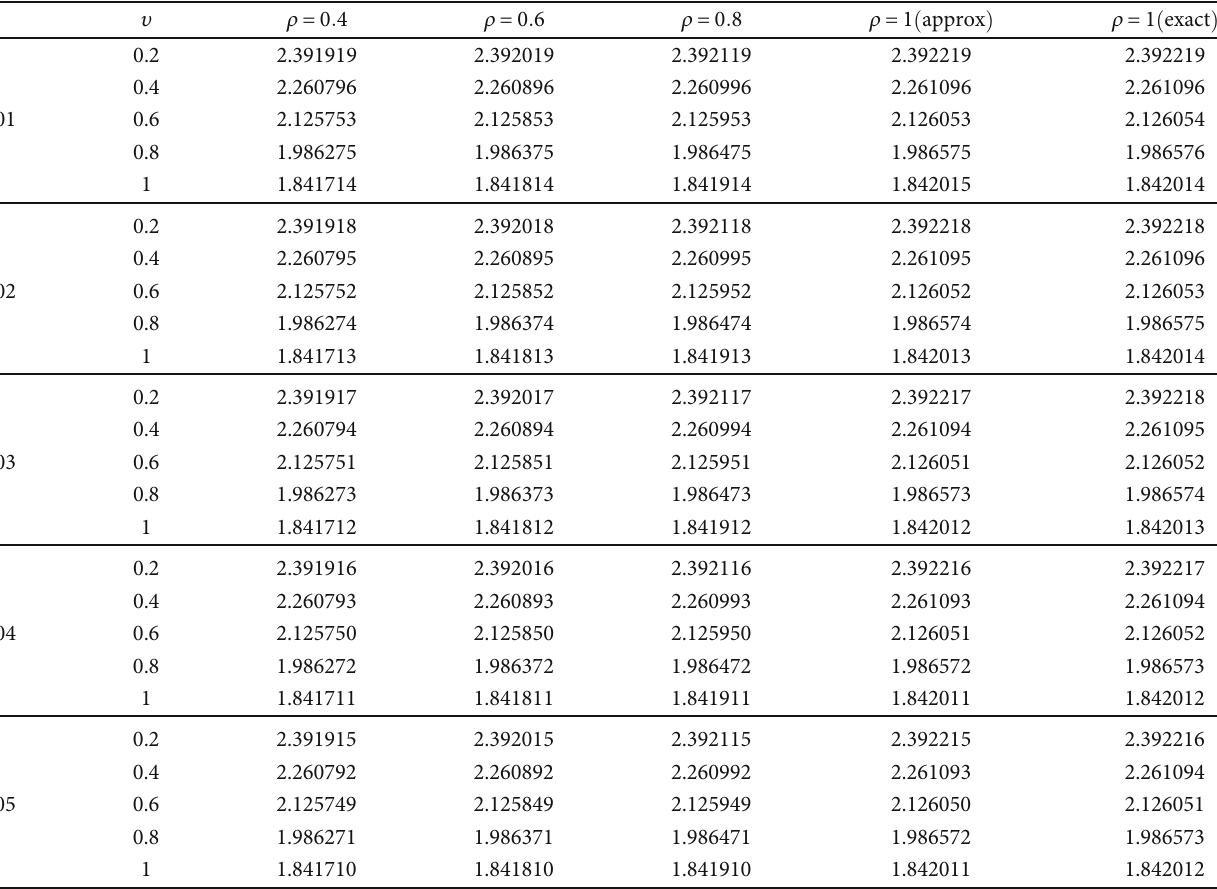
Table 3: Comparison of the exact and proposed method solution at various values of ρ with a , b = 1 for problem